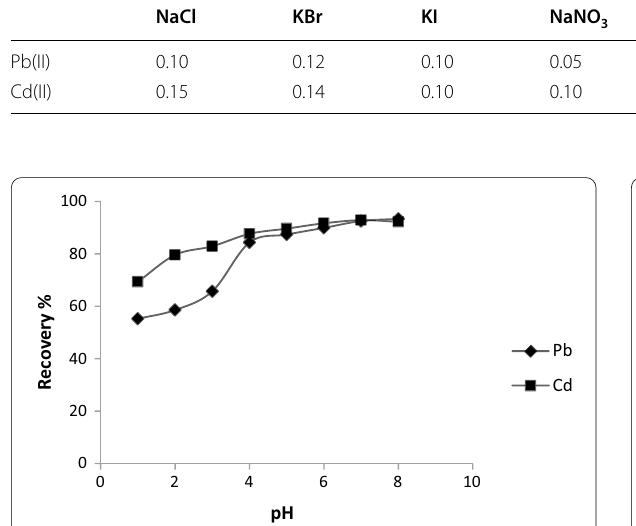
Fig. 2 Effect of pH on the recovery of Pb(II) and Cd(II) by modified Amberlite XAD-4 resin (adsorbent amount: 0.2, initial metal concentration: 20 mg/L, flow rate: 2.5 mL/min)